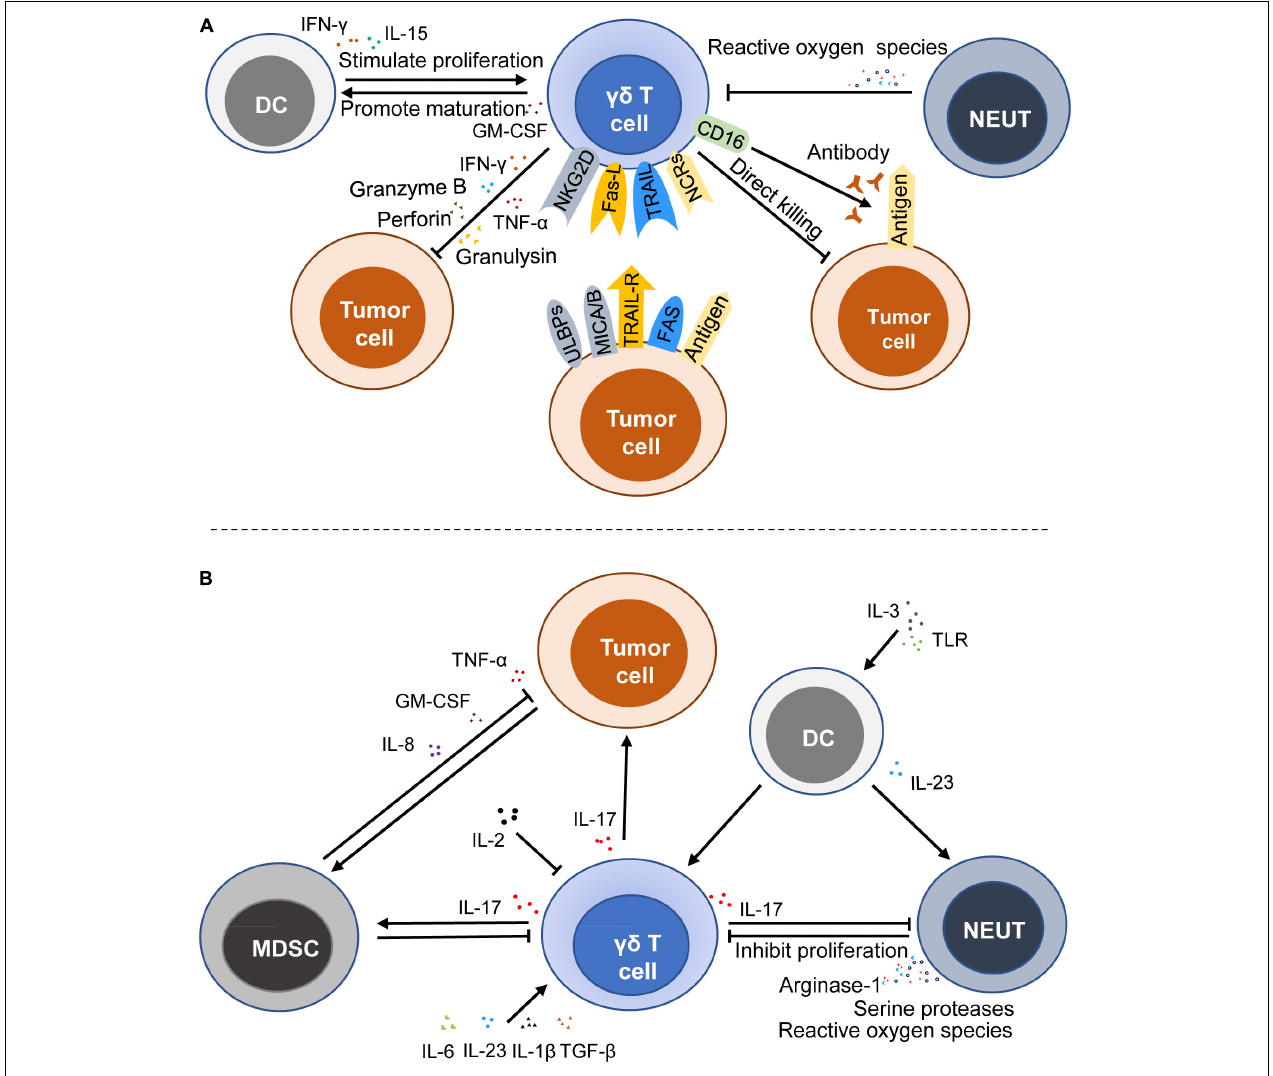
FIGURE 2 | Immune functions of γδ T cells in cancers. γδ T cells can exert an antitumor effect by a direct killing effect, death receptor signal pathway, ADCC, and secreting cytokines and chemokines (A) , whereas γδ T cells can stimulate and promote the growth and progression of cancer cells by producing IL-17 (B) . MDSC, myeloid-derived suppressor cell; DC, dendritic cell; NEUT, neutrophil; NCRs, NK cell receptors; ULBPs, UL16-binding proteins; NKG2D, natural killer group 2, member D; MICA/B, MHC Class I-related sequence A and B; TRAIL, TNF-related apoptosis-inducing ligand; TRAIL-R, TNF-related apoptosis-inducing ligand-receptor; Fas-L, fas ligand; ADCC, antibody-dependent cytotoxicity; GM-CSF, granulocyte-macrophage colony stimulating factor; TLR, toll-like receptor; TNF- α , tumor necrosis factor- α .